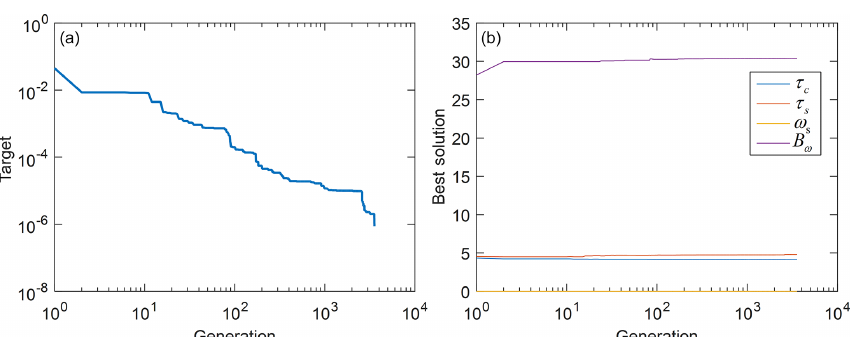
Figure 9. Parameter identification process of friction model. (a) The objective function changes with generations; (b) the elite individual changes with